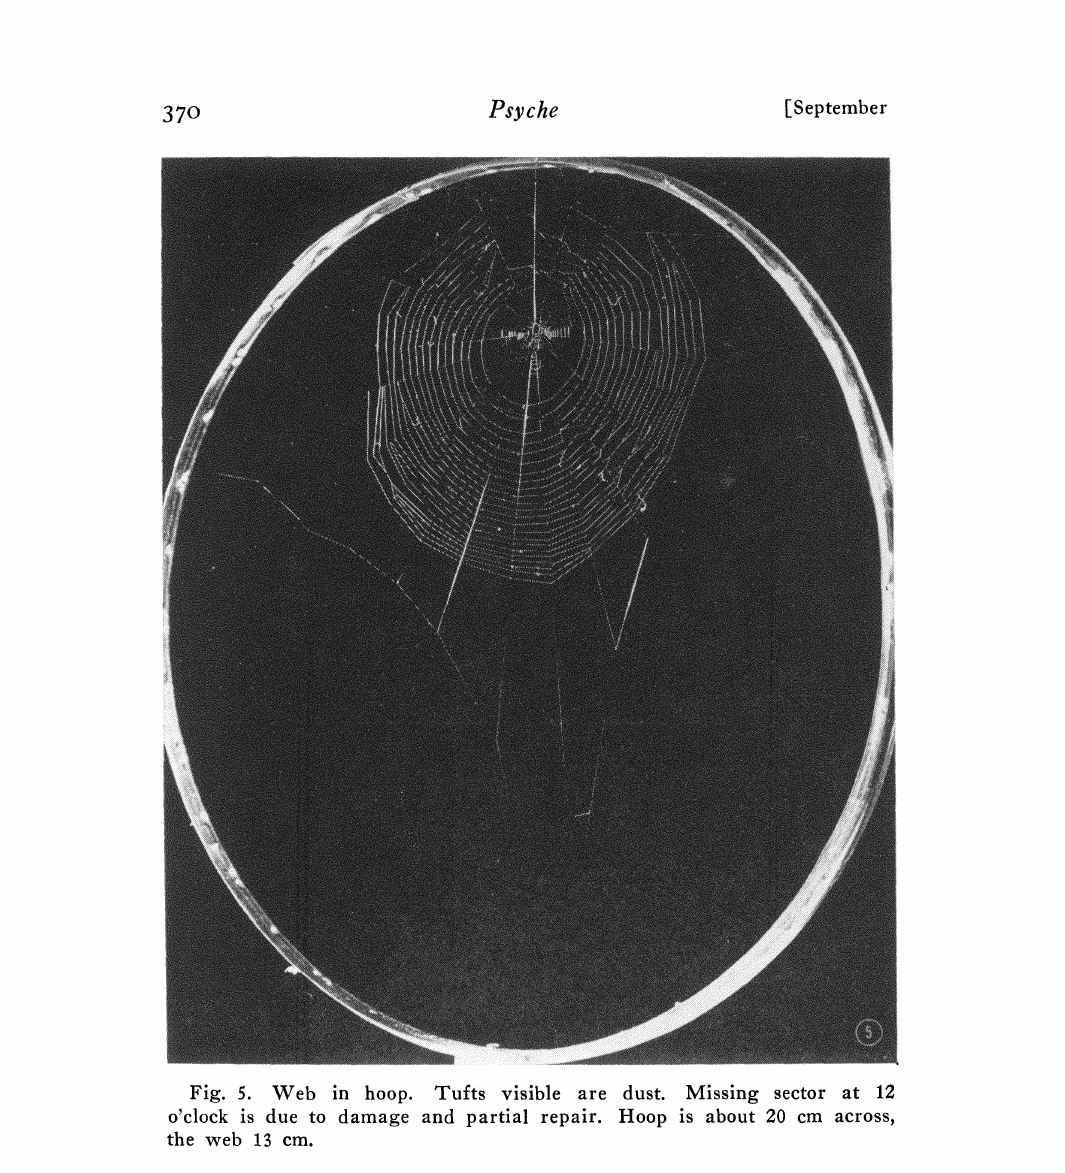
Fig. 5. Web in hoop. Tufts visible are dust. Missing sector at 12 o’clock is due to damage and partial repair. Hoop is about 20 cm across, the web 13